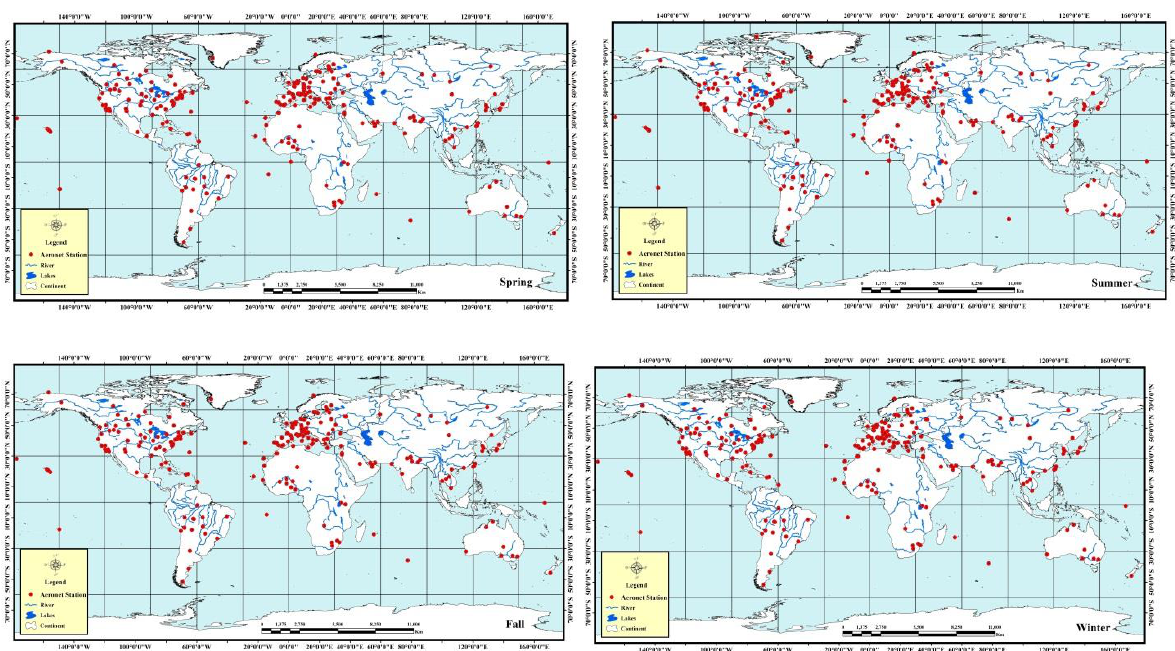
Fig. 1 Map of AERONET stations used in this study. a) Map of the 236 AERONET stations during the spring season. b) Map of the 239 AERONET stations during the summer season. c) Map of the 239 AERONET stations during the fall season. d) Map of the 202 AERONET stations during the winter